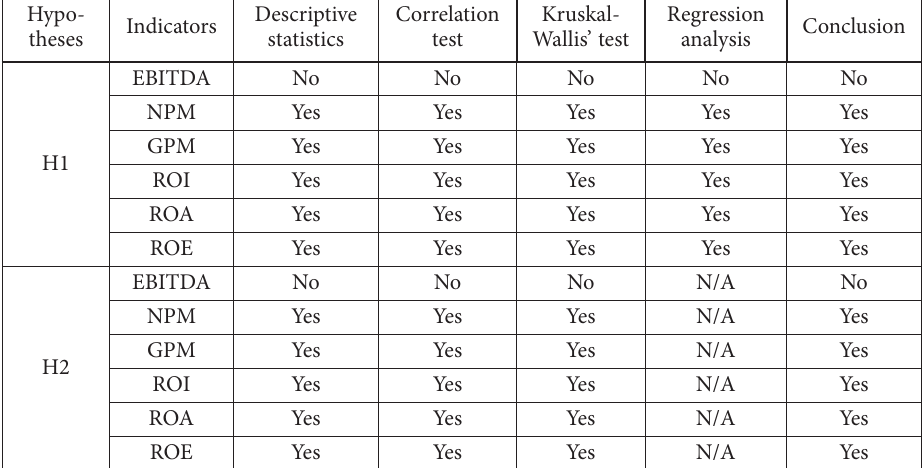
Descriptive statistics